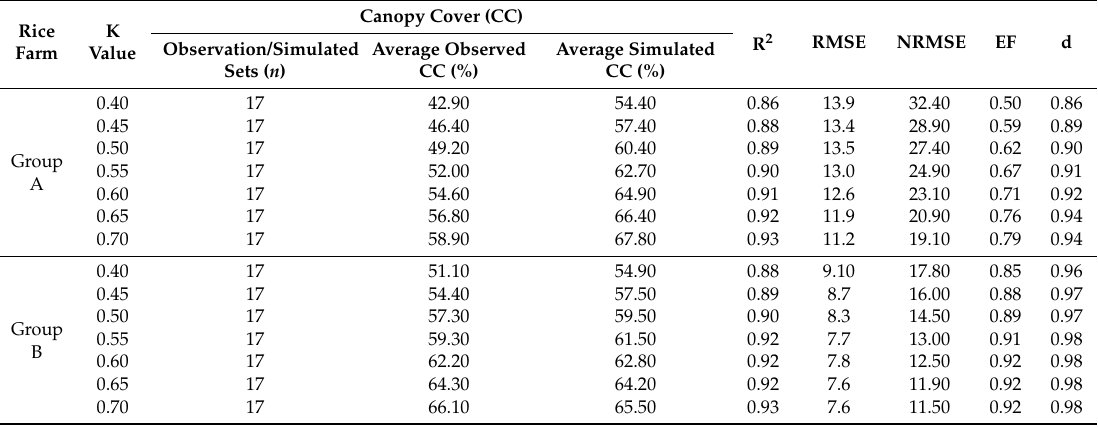
Figure 4. The relationship between the measured average LAI and rice age for sample LAI mean of rice. Graph ( a ) was presented the relationship of rice in groups A and graph ( b ) for rice group B; error bar represents standard deviation of field measurement.